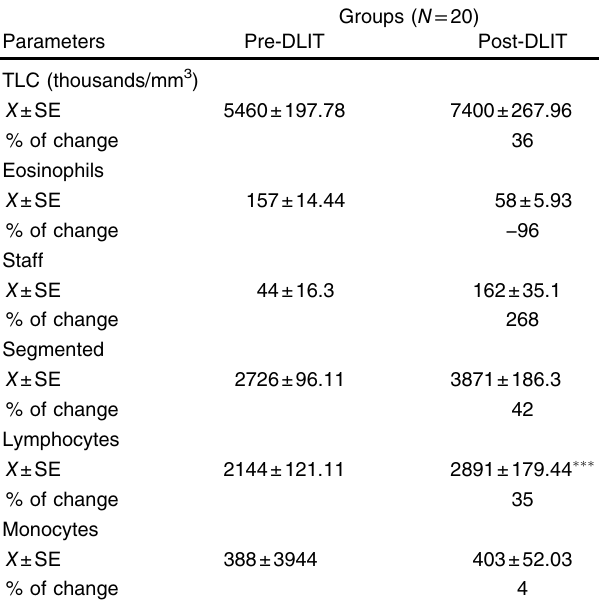
Table 3 Statistical analysis of IgE, IL-4, IL-5, and IFN- γ values before and after DLIT